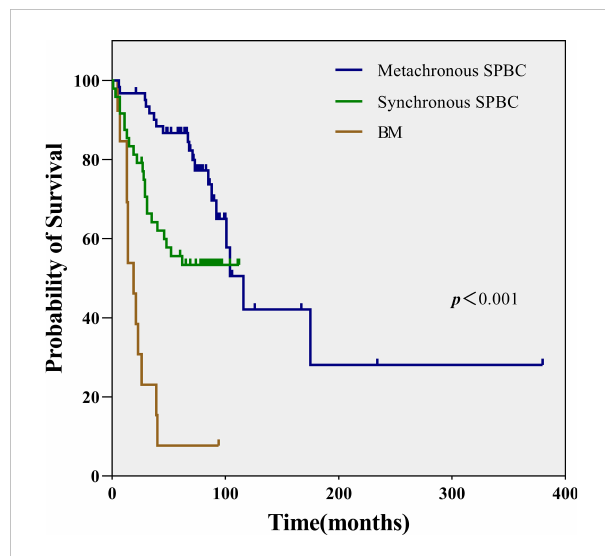
FIGURE 3 Survival comparison of metachronous group, synchronous group and breast metastases group.